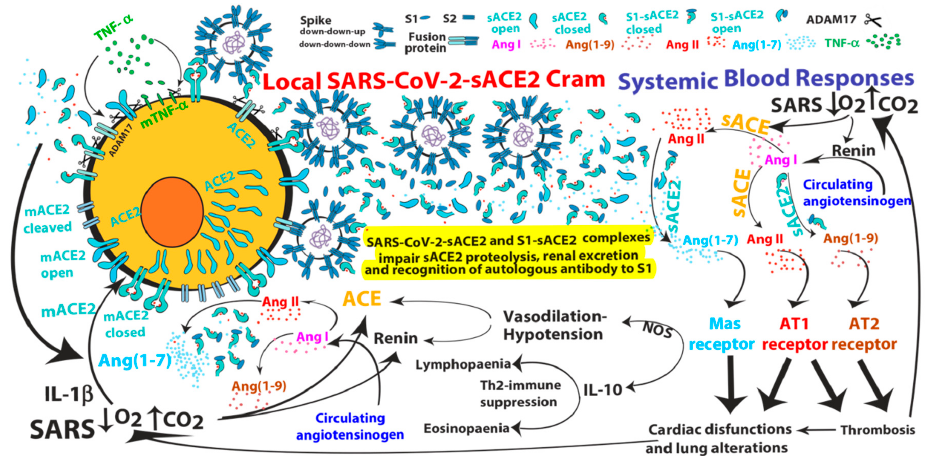
Figure 2. SARS-CoV-2 induced positive feedback loops mediated by RAS activation and pathophysiological consequences of the systemic excess of circulating ACE2 enzyme. (for reference, see the text).